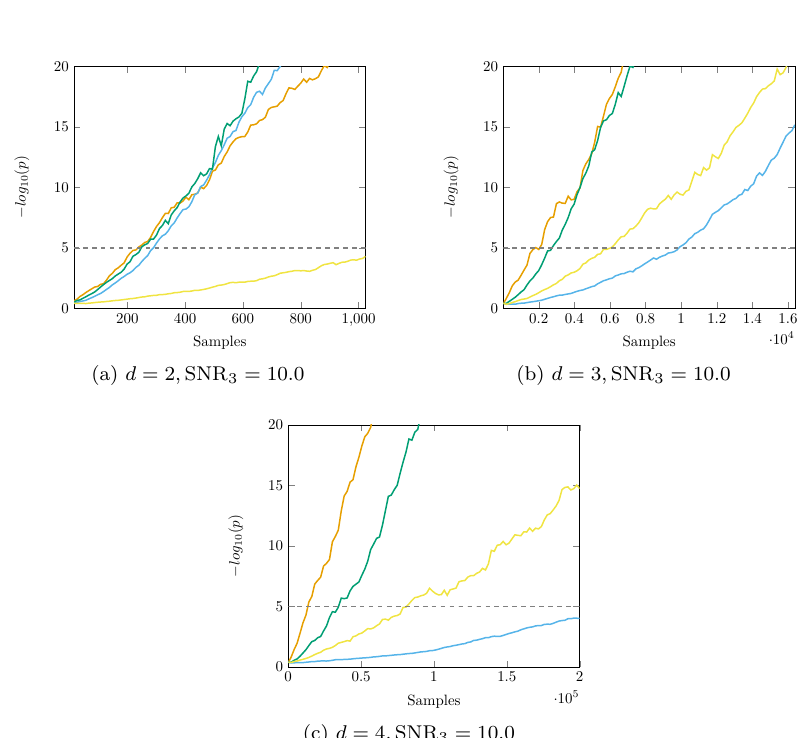
Figure 14: Performance of the (orange) t -test with normalized product, (green) χ 2 -test with normalized product, (yellow) χ 2 -test with sum combining, and (blue) χ 2 -test with multivariate histograms for simulated multivariate 2nd-, 3rd-, and 4th-order leakages with SNR 3 = 10 .